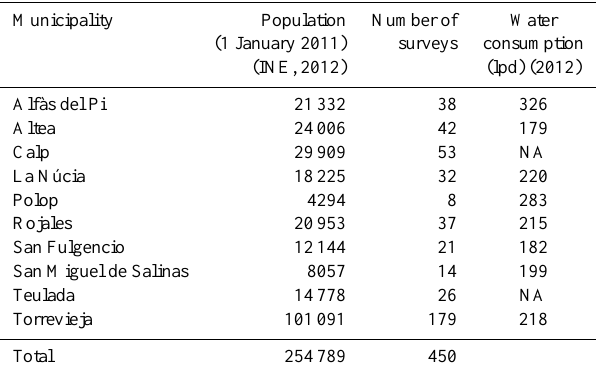
Table 1. Sample of municipalities, population, number of surveys and domestic water